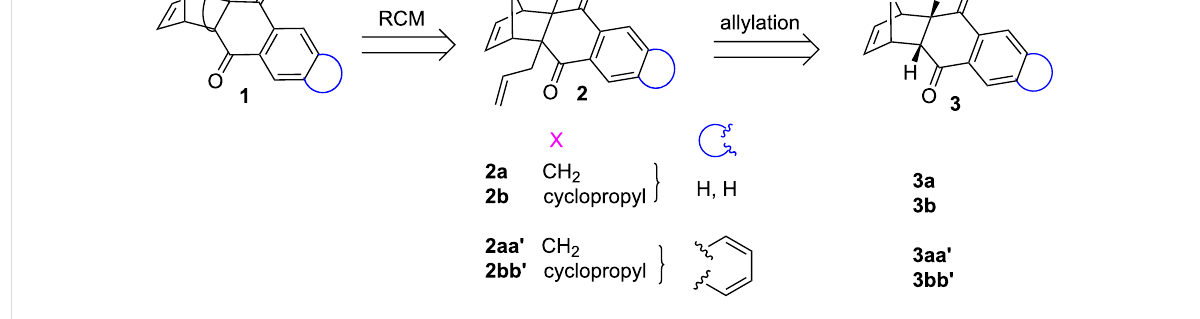
Figure 1: Retrosynthetic approach to propellane derivatives.